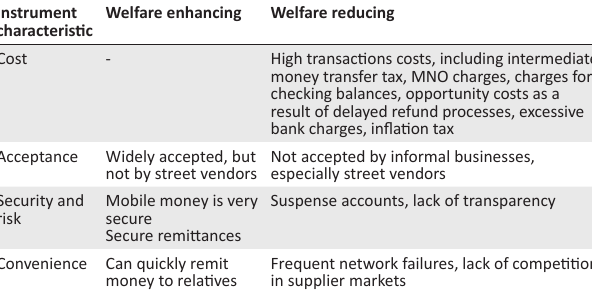
TABLE 3: Welfare effects of e-payments. Instrument Welfare enhancing Welfare characteristic